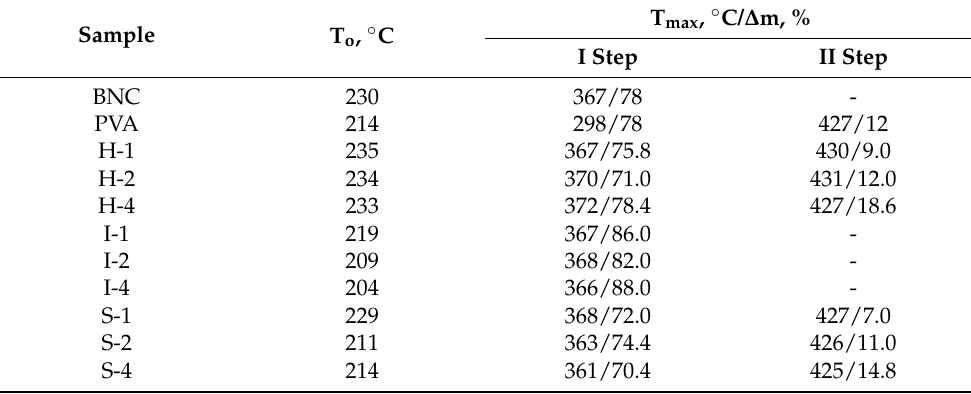
Table 5. Thermal parameters determined from the TG and DTG curves of all tested samples.